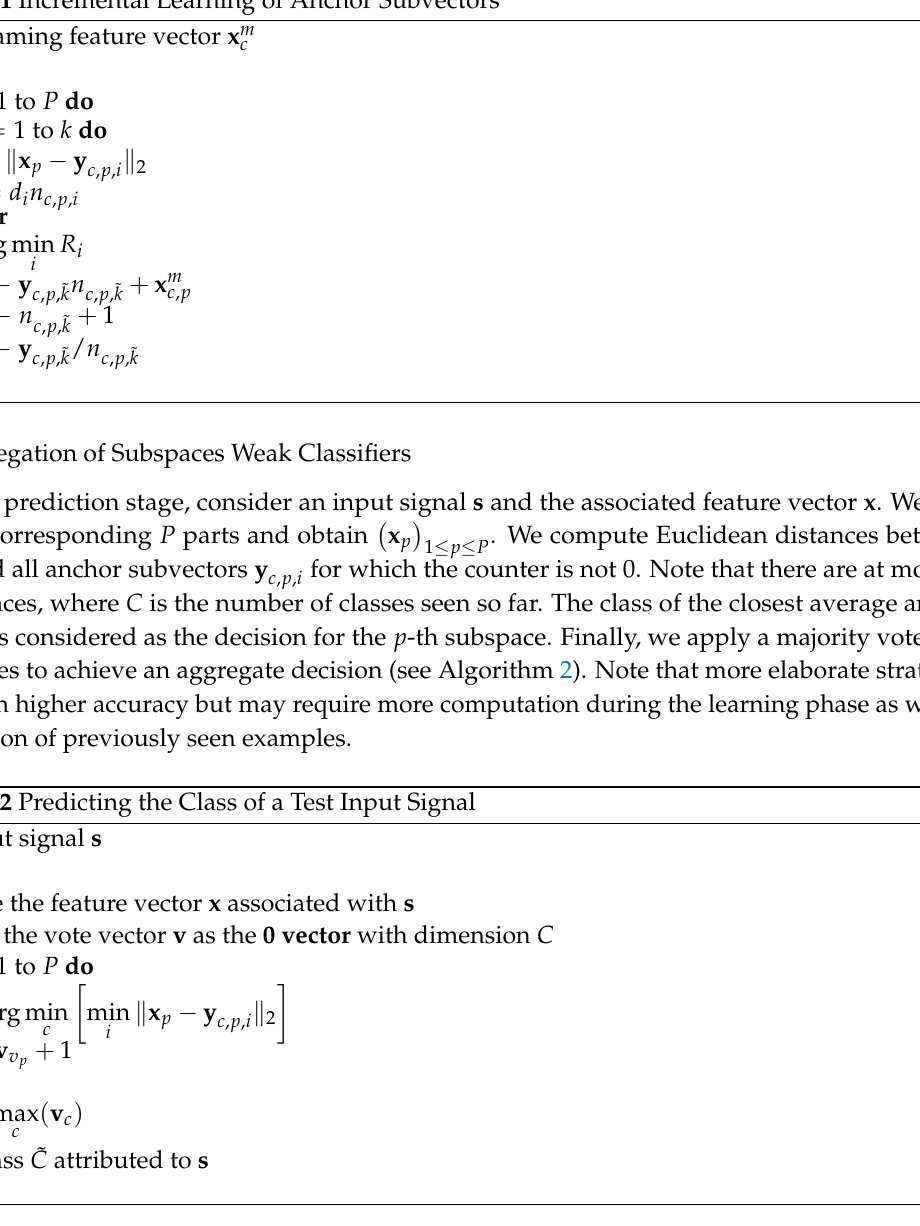
Algorithm 1 Incremental Learning of Anchor Subvectors